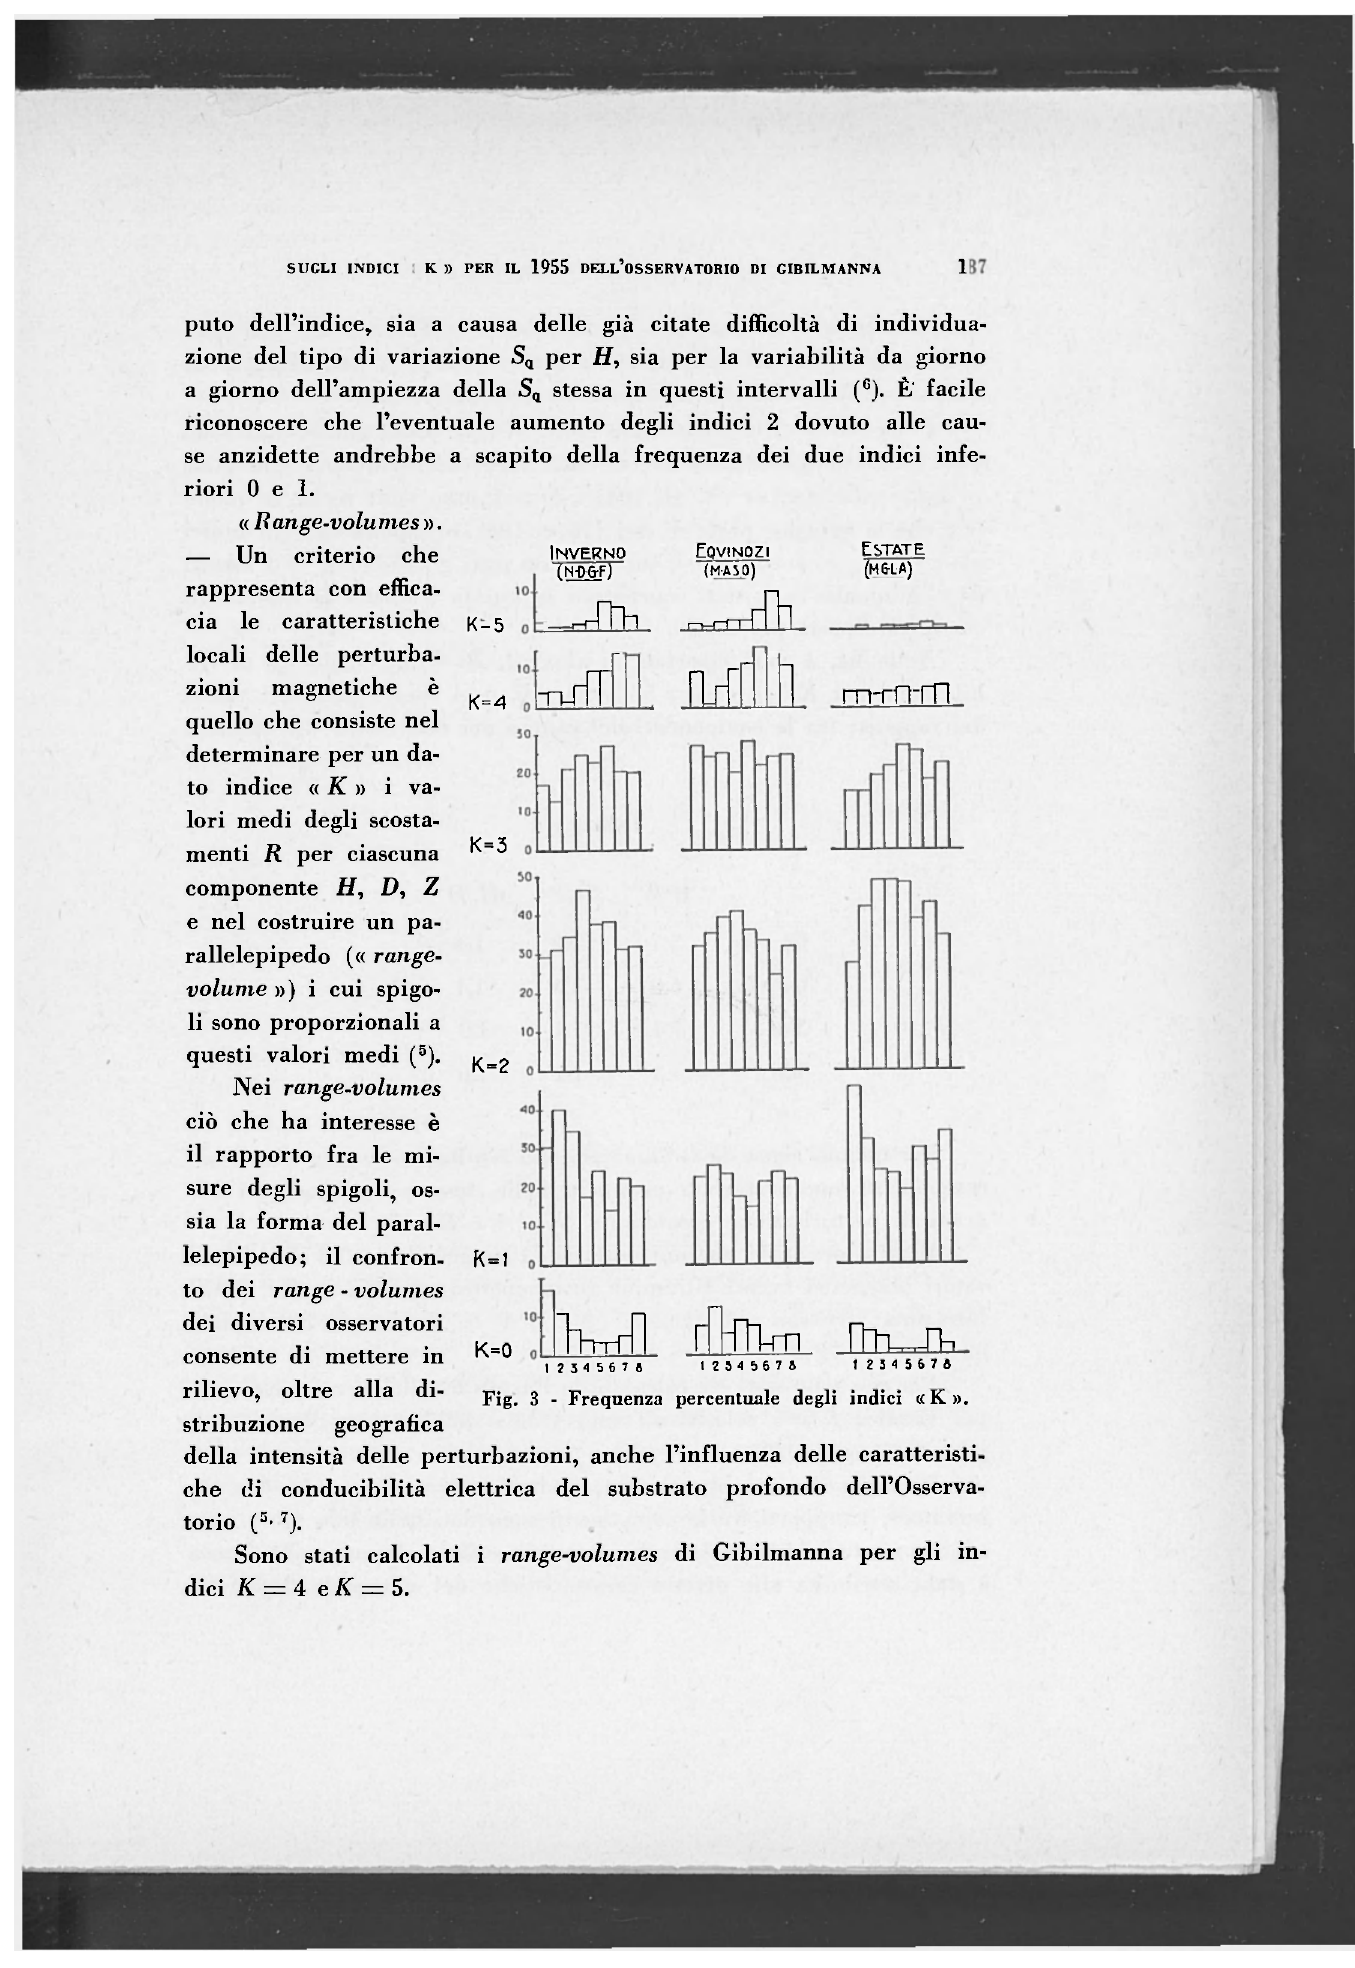
Fig. 3 - Frequenza percentuale degli indici « K